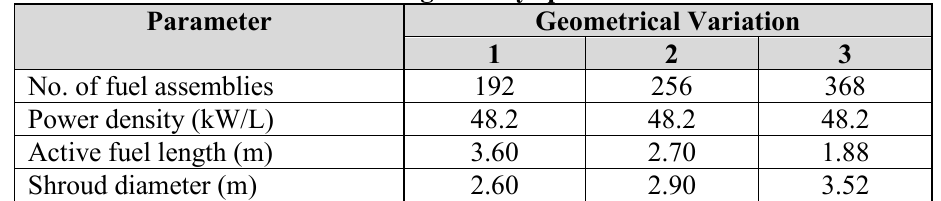
Table I. Core geometry specification.